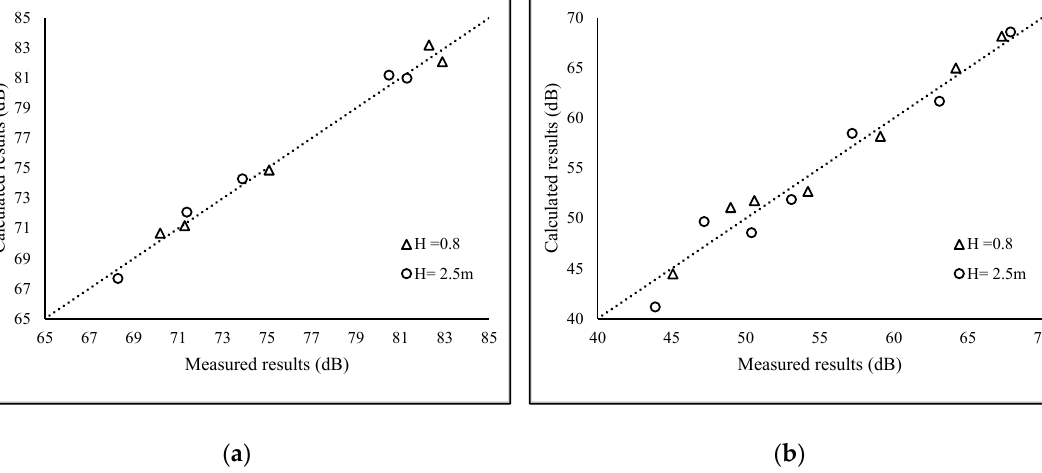
Figure 5. The correlation analysis of the measured and calculated data. ( a ) Direct transmission and reflection calculation; ( b ) diffraction or composition beam calculation.